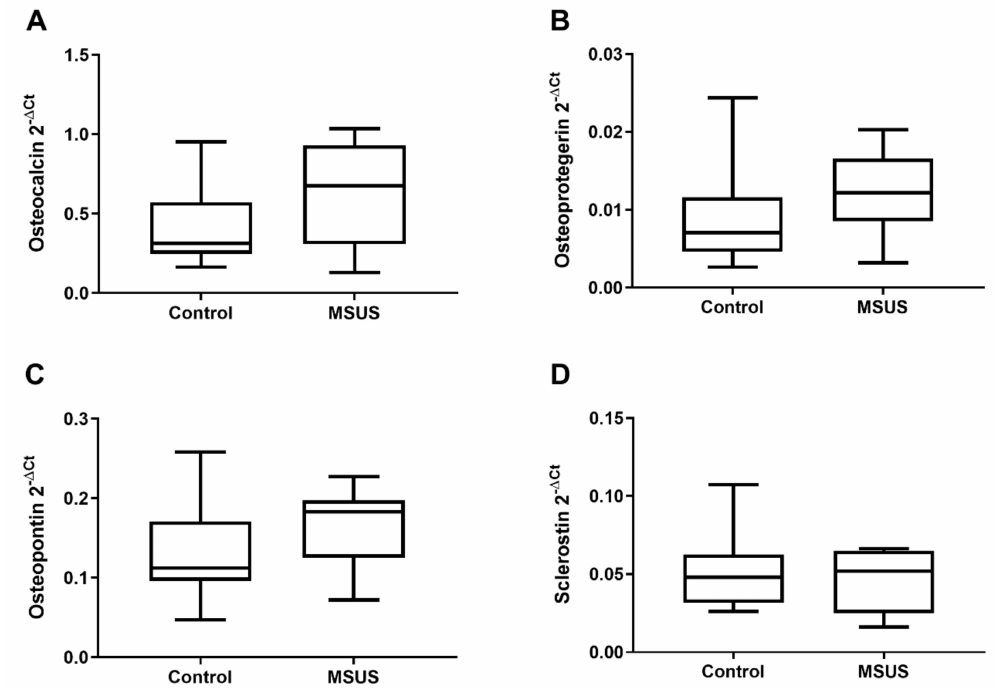
Figure 5. Gene expression of extracellular matrix in bone of mice. Shown are the gene expressions of tissue-specific extracellular matrix markers in bone of controls and MSUS. Genes include osteocalcin ( A ), osteoprotegerin ( B ), osteopontin ( C ) and sclerostin ( D ). Data ( n = 8 per group) are expressed as Min to Max of 2 − dCt . Significance level: all p >